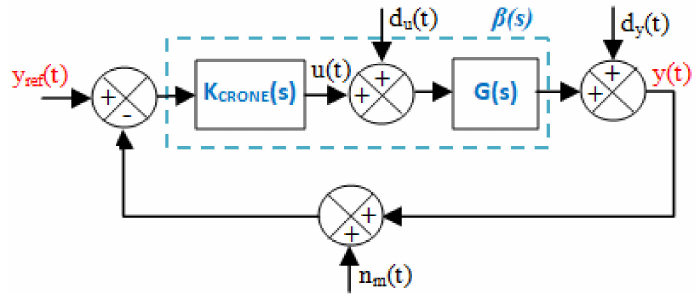
Figure 5. CRONE Control System Design diagram.